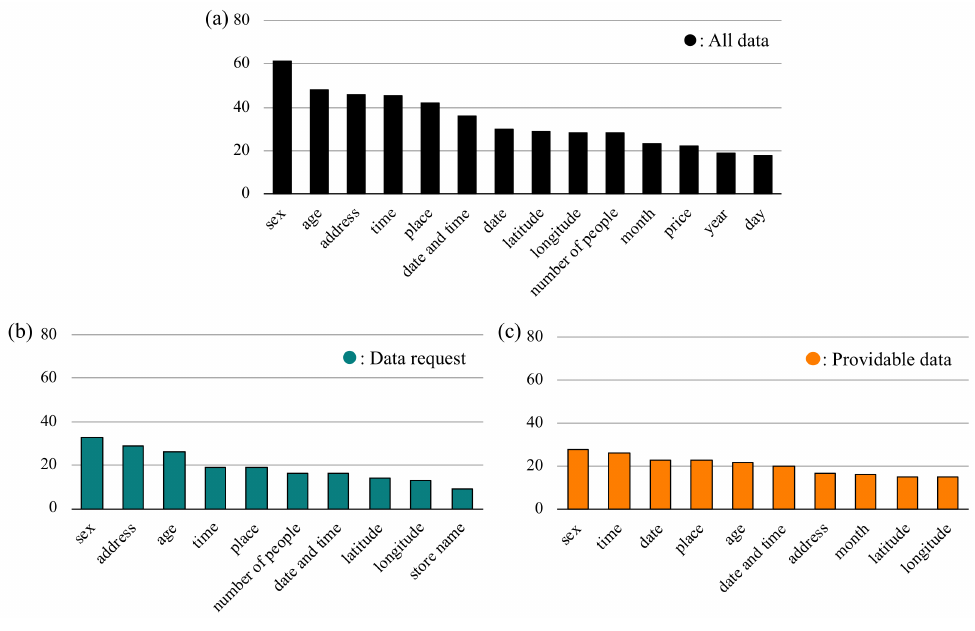
Figure 2. ( a ) The top 15 variables in the data requests and providable data. ( b ) The top 10 variables in the data requests. ( c ) The top 10 variables in the providable data.